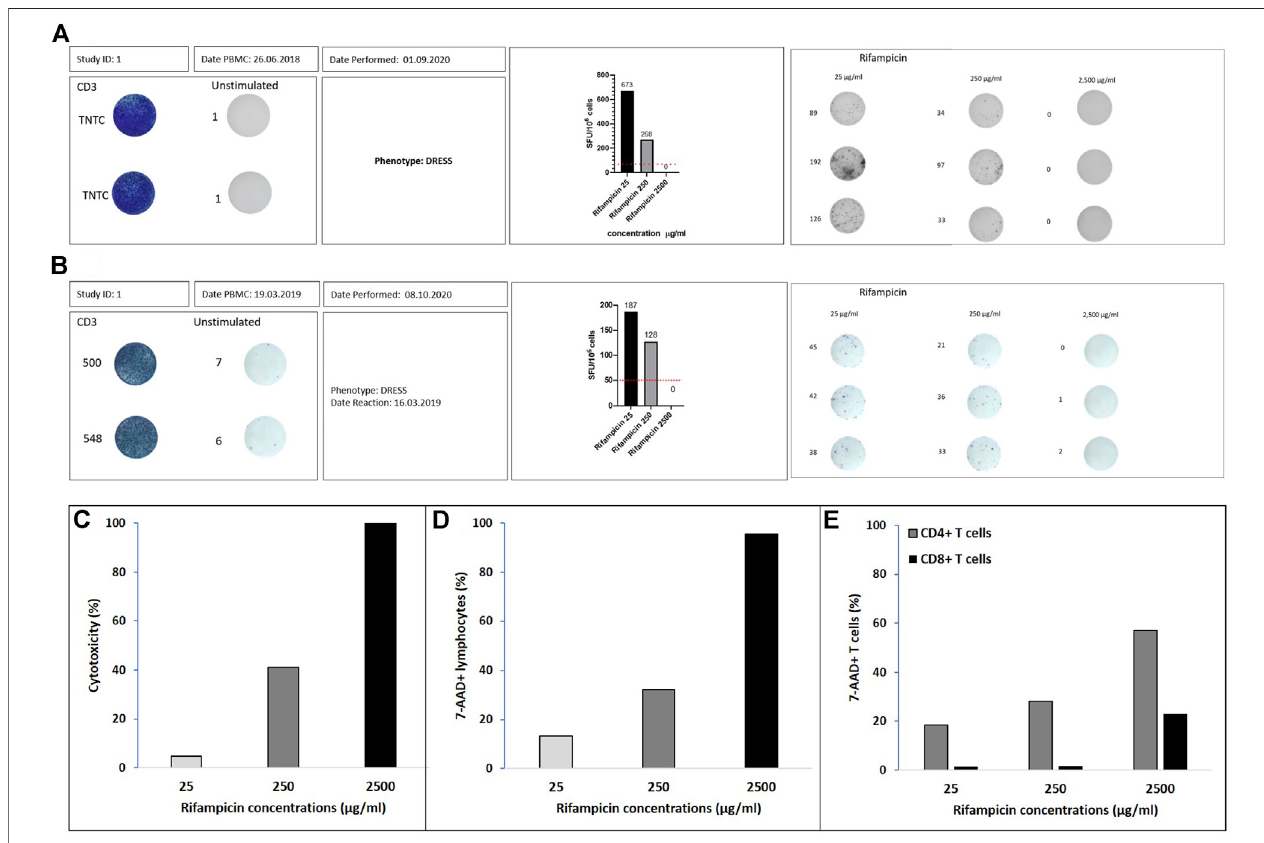
FIGURE1 | Rifampicin DRESS patients. IFN- γ ELISpot graphical illustration of (A) Australian patient and (B) south African patient. Positivity isde fi ned by ≥ 50spot forming unit (SFU)/million cells after background (unstimulated control) removal (dotted line on the corner right fi gures). Positive controls were done using CD3 and the unstimulated wells represent media alone. The stimulations with the different drug concentrations (µg/ml) were done in triplicates. The numbers adjacent to the wells representthenumber ofspots measured withthe ELISpotreader.ELISpot graphicalillustration forRifampicin 25, 250,and 2500 μ g/ml.Percentage ofcytotoxicity assessedby (C) LDHassay, (D) fl owcytometrywith7-AADviabilitystaininginlymphocytesand (E) fl owcytometrywith7-AADviabilitystaininginCD4 + andCD8 +